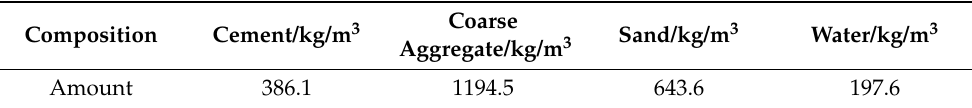
Table 3. Mix design of concrete.